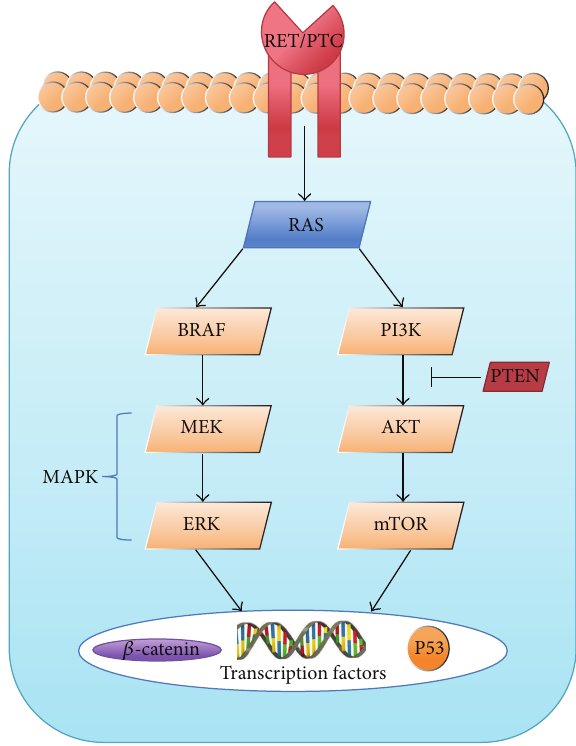
Figure 3: This diagram summarizes the signaling pathway in thyroid